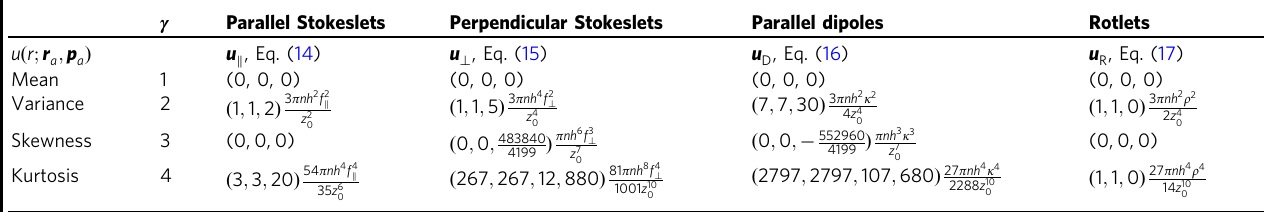
Table 1 Properties of fl uctuations driven by an active carpet.